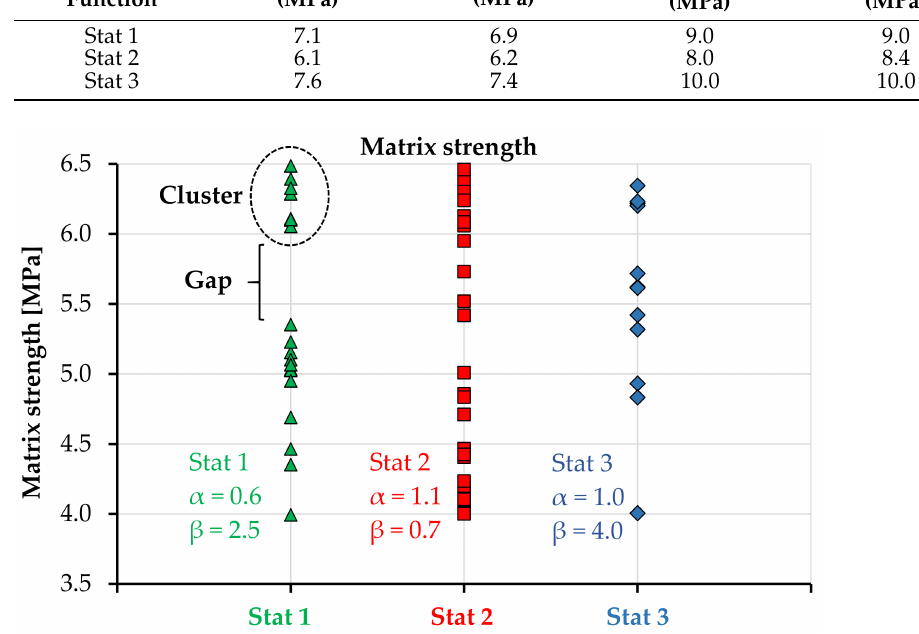
Figure 9. Number and spacing of the matrix strength values in the generated arrays up to the macroscopic tensile strength (6.5 MPa) depending on probability distribution.